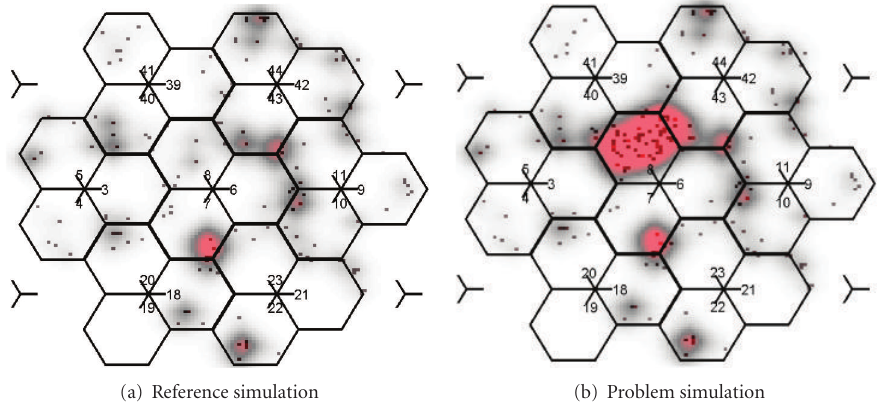
Figure 8: RLF-labeled samples on the map grid.